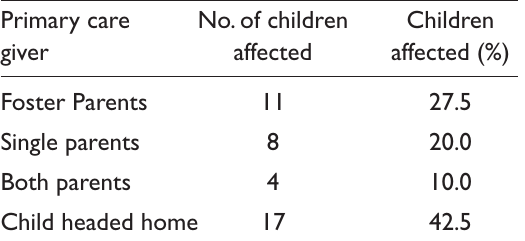
Table 2. Categories of Primary Care Givers for the Children on